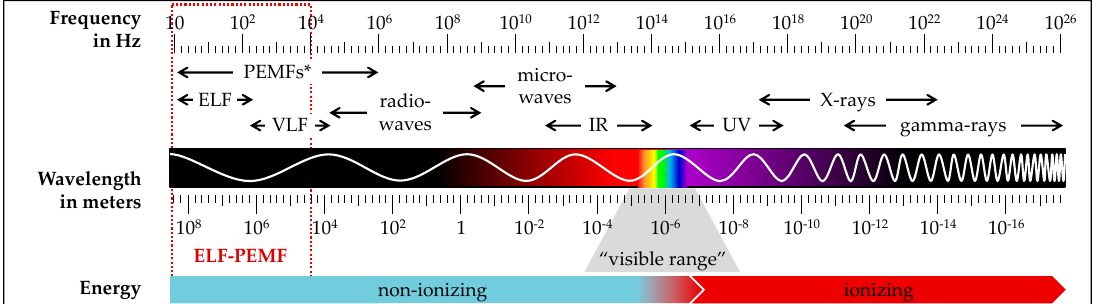
Figure 1. The electromagnetic spectrum with its characteristic frequencies, wavelengths, and electromagnetic energy. The electromagnetic spectrum ranges from extremely long wavelengths with small frequencies (e.g., ELFs (extremely low frequency) and VLFs (very low frequency)) to extremely short wavelengths with high frequencies (e.g., UV (ultraviolet), x-rays or gamma-rays). Depending on the wavelength and frequency, it comprises both nonionizing and ionizing radiation. * In case for pulsed electromagnetic fields (PEMFs), “frequency” and “repetition rate” are often used synonymously, knowing that lower-frequency electromagnetic pulses are super-positioned by higher frequencies, yielding a wider frequency spectrum. The range of extremely low frequency pulsed electromagnetic fields (ELF-PEMFs) considered in this review is marked in red.